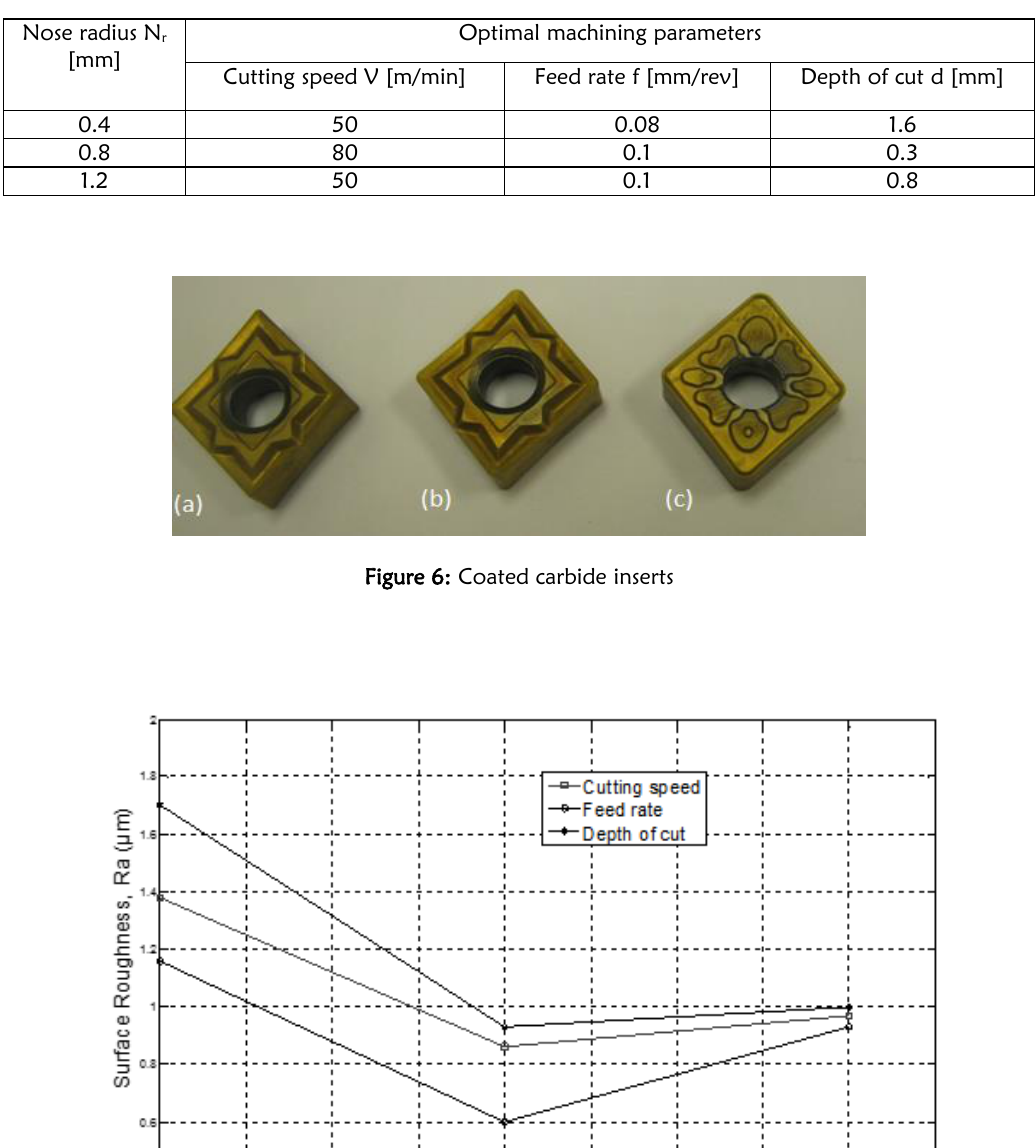
Table 3: Optimal machining parameters for Stellite 6 using coated carbide tools